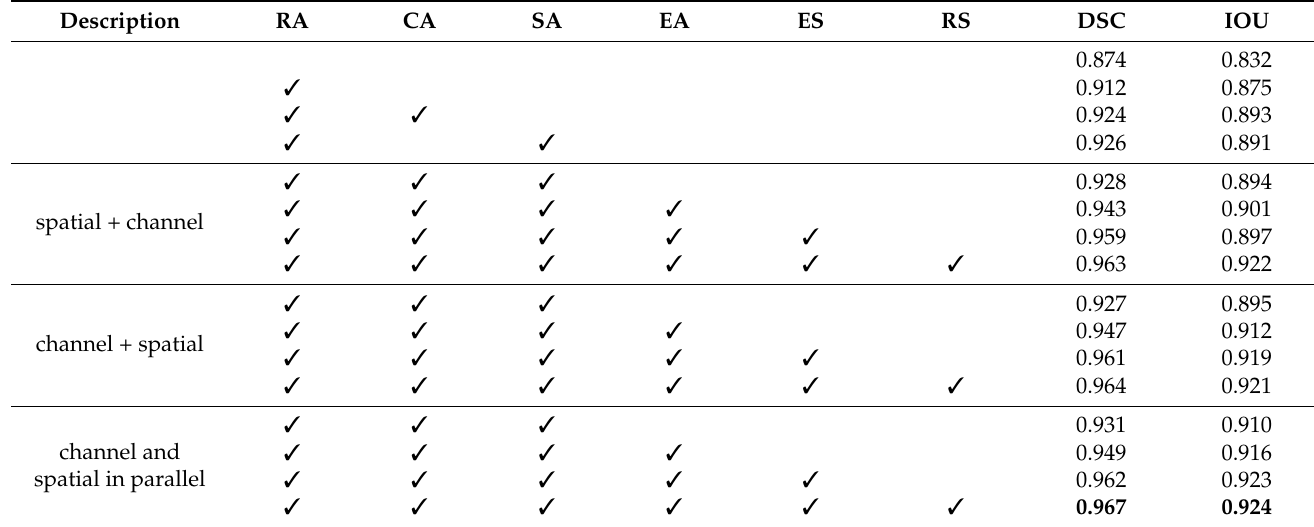
Table 4. The performance evaluation of each network component in the proposed model based on two metrics. The network components include RoI Align sampling operation (RA), channel attention (CA), spatial attention (SA), edge attention (EA), edge supervision (ES), and region supervision (RS), the (cid:51) represents adding the component to the model for experiments.